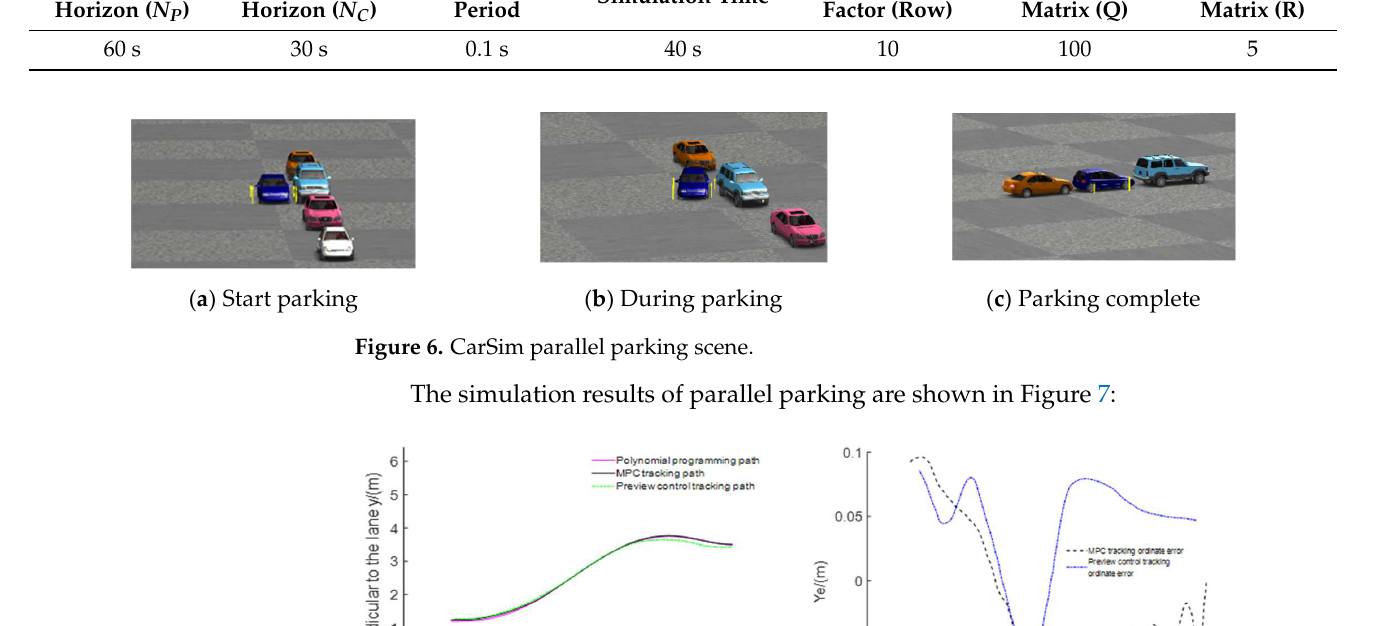
Table 3. MPC controller basic parameters.